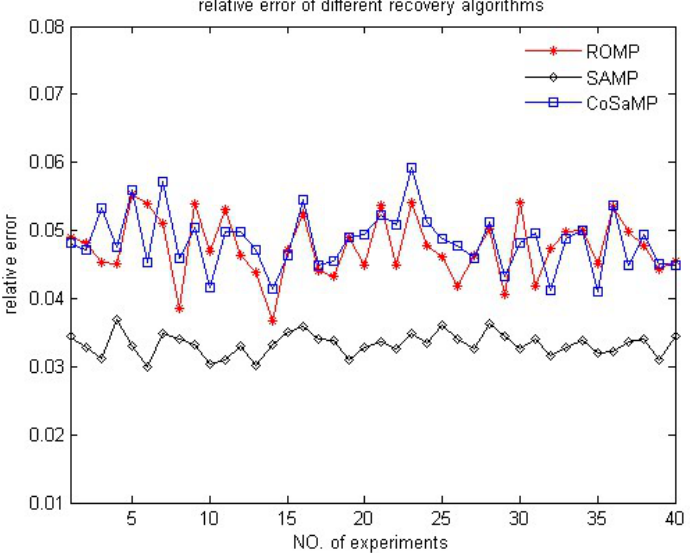
Figure 14. Comparison of relative recovery error ( REE ) among three recovery algorithms.